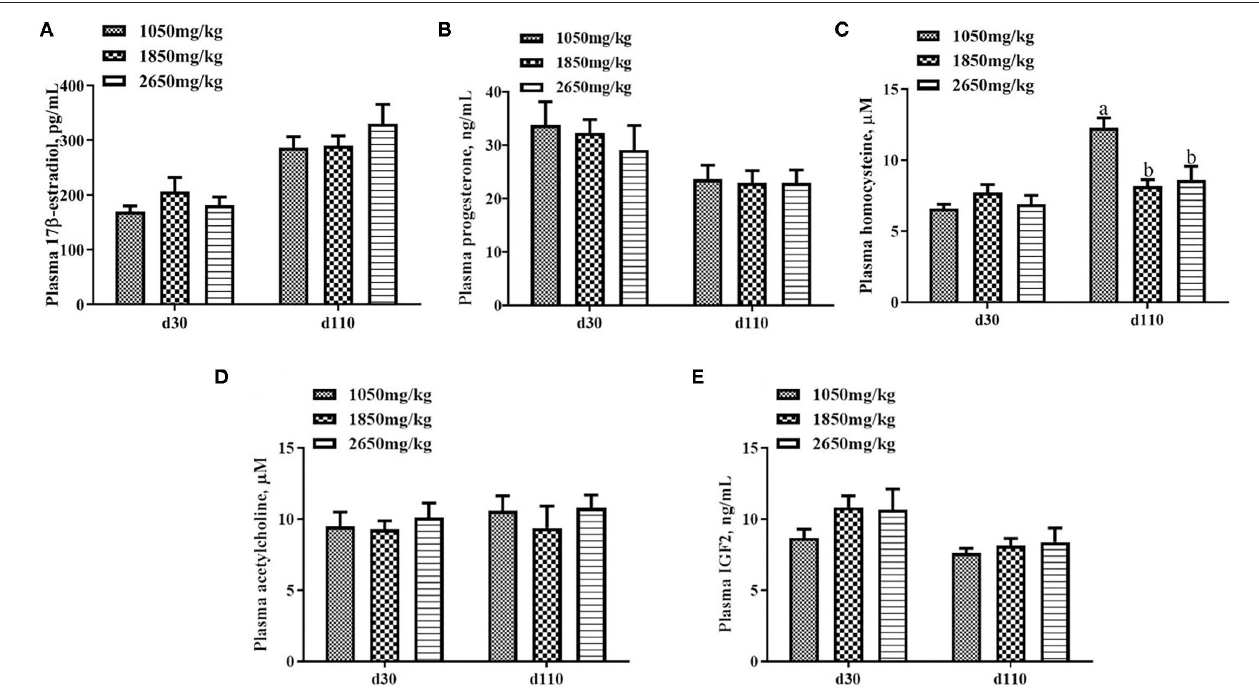
FIGURE 1 | Effect of dietary choline levels during gestation on the plasma concentrations of 17 β -estradiol (A) progesterone, (B) HCY, (C) acetylcholine, (D) IGF 2 , and (E) at days 30 and 110 of gestation. Data are expressed as mean values with their standard errors, N = 8 for each treatment. a, b Mean values with unlike letters were significantly different ( P <